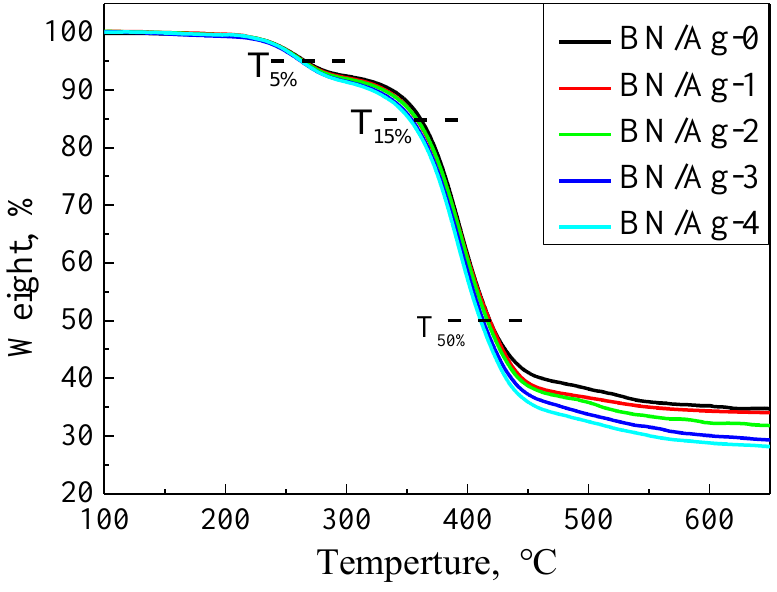
Figure 6. TGA curve of BN/AgNWs/EP Composites. Table 3. T 5% , T 10% and T 50% temperatures of BN/AgNWs/EP Composites.